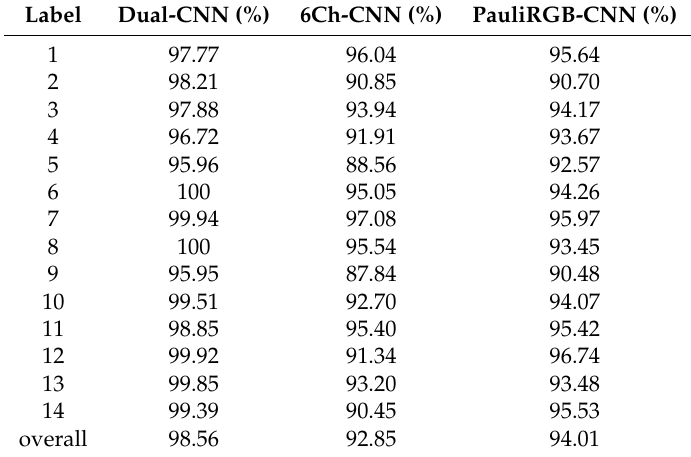
Table 2. The detailed classification accuracy of the Dual-CNN, 6Ch-CNN, and PauliRGB-CNN on Flevoland PolSAR